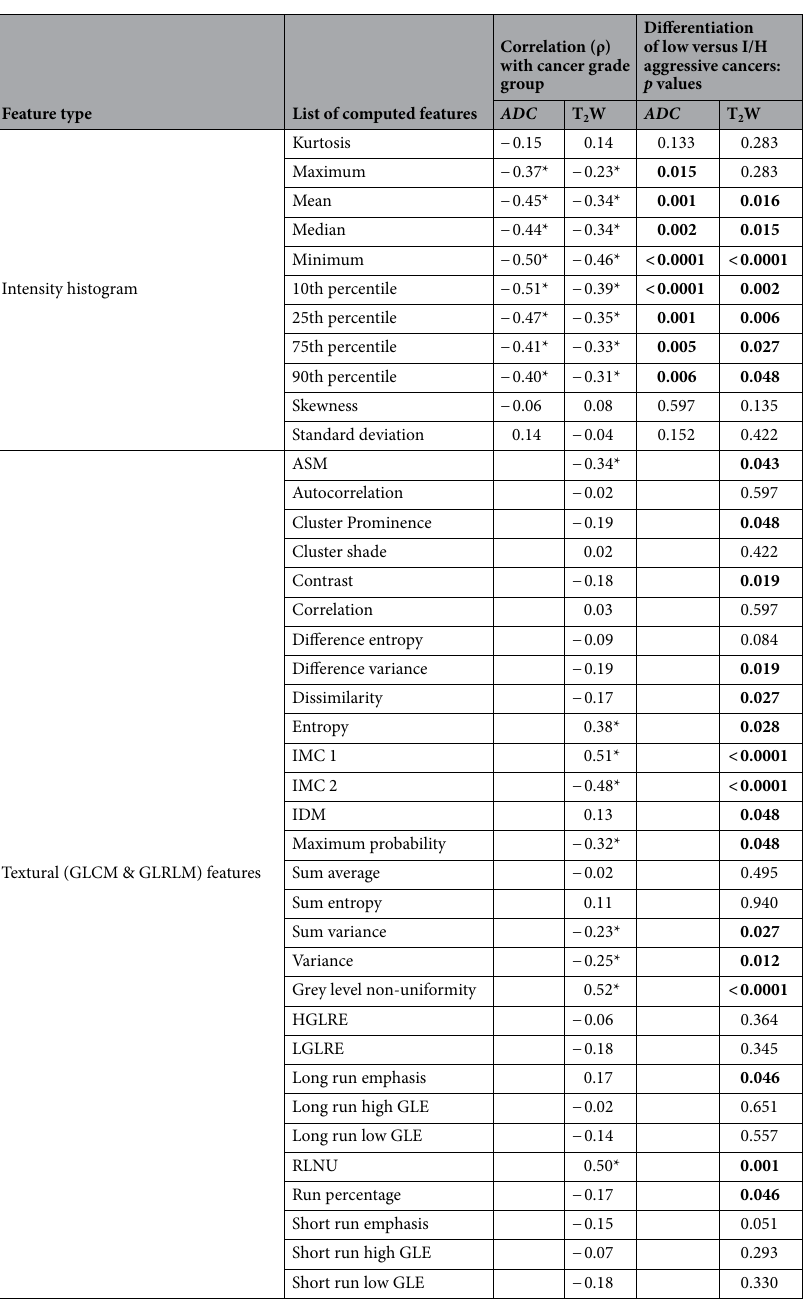
Table 2. List of computed features from T 2 -weighted images and ADC maps, and their association with prostate cancer aggressiveness. Bolded p values indicate features differed significantly between low- (grade group 1) and I/H-aggressive (grade group ≥ 2) prostate cancers. ASM angular second moment, IMC information measure of correlation, IDM inverse difference moment, HGLRE high grey level run emphasis, LGLRE Low grey level run emphasis, GLE grey level emphasis, RLNU run length non-uniformity, I/H intermediate/high, ρ spearman correlation coefficient between features and cancer grade groups. *Indicates feature correlated significantly with cancer grade group. The correlation coefficients were calculated for the entire grade groups (i.e. 1–5) and not for the dichotomized aggressive classes (i.e. grade groups 1 and ≥